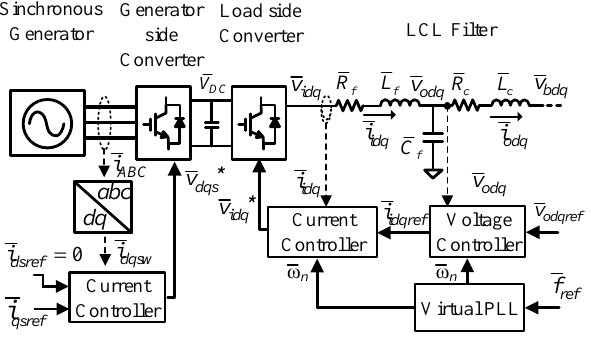
Figure 4. Schematic diagram of the controllers of the two converters.